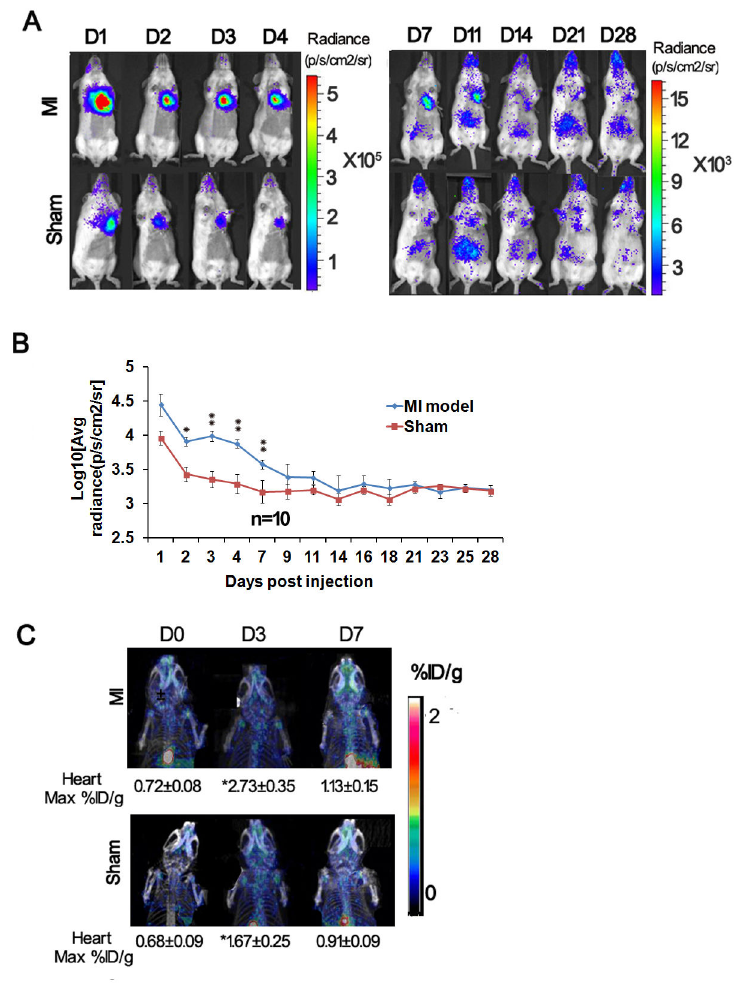
Figure 7. Bioluminescence imaging of transplanted MSCs in mice with myocardial infarction (MI) and sham model. (A–B) Mice in both sham and MI groups received 1 million MSCs by intramyocardial injection (n=5). To assess longitudinal cell survival, animals were imaged for 4 weeks. A representative image of mice injected with MSCs showed significantly higher bioluminescence signal in MI heart (top) than in sham heart (bottom) signals at day 2 (p<0.05), day 3, day 4, day 7 (p<0.01). In both groups, bioluminescence signals decreased to background levels after 4 weeks. p/s/cm 2 /sr=photons per second per cm 2 per steradian; p/s = photons per second. (C) Micro-PET imaging of the same mice. Following a bioluminescence scan, the mouse was imaged in microPET using FHBG on day 0, 3 and 7. Higher microPET signal was found in the infarcted heart in day3. (٭٭P<0.01, *